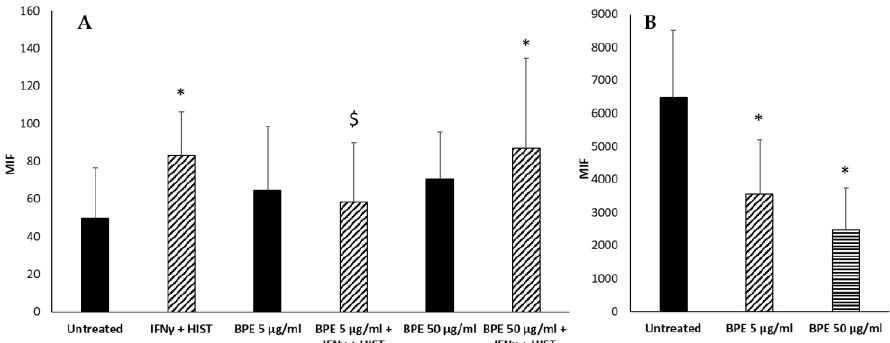
Figure 15 . Effect of BPE on intracellular ROS production of HuDe ( A ) and NCTC 2544 ( B ) cells. The experiment was performed in quadruplicate for each substance. The statistical analysis was performed with a two-tailed Student ’s t- test. * p < 0.05 (BPE-treated cells vs. untreated cells); $ p < 0.05 (BPE-treated cells vs. IFNγ +-HIST-treated cells).